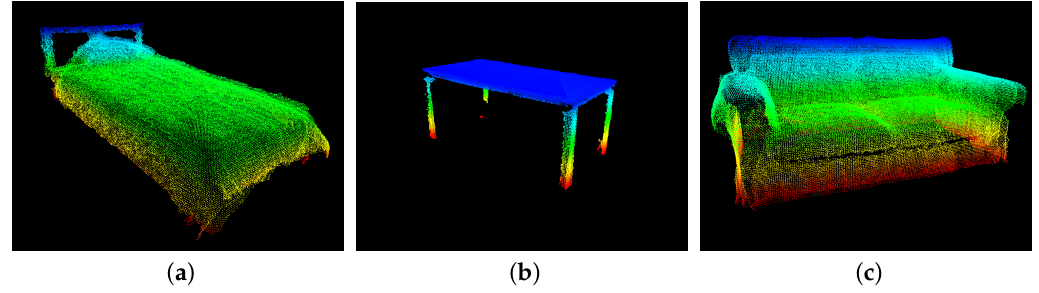
Figure 4. Example of the created models, for ( a ) a bed, for ( b ) a table and for ( c ) a